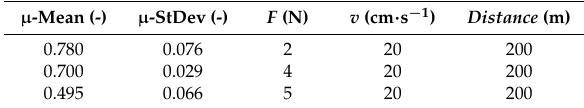
Table 5. The friction coefficient measured via Pin-On-Disc test.